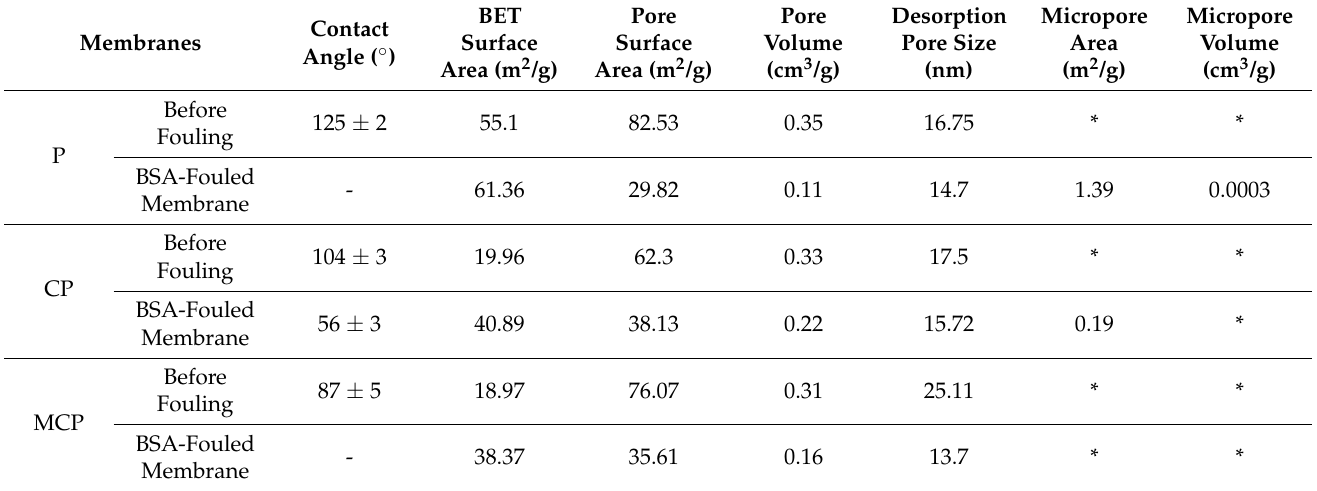
Table 1. Surface properties of the membranes before and after BSA